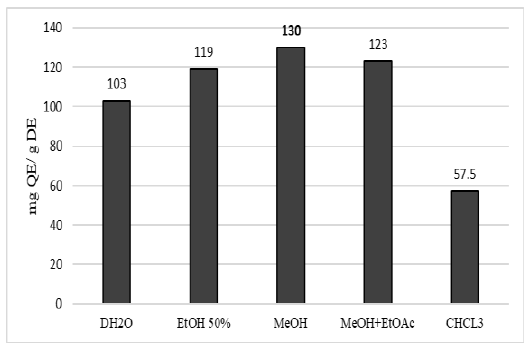
Figure 6. TFC in 1 g of the dried extracts All results of TFC are presented as the mean of three replicates ± SD ( p < 0.05) RSA of the extracts